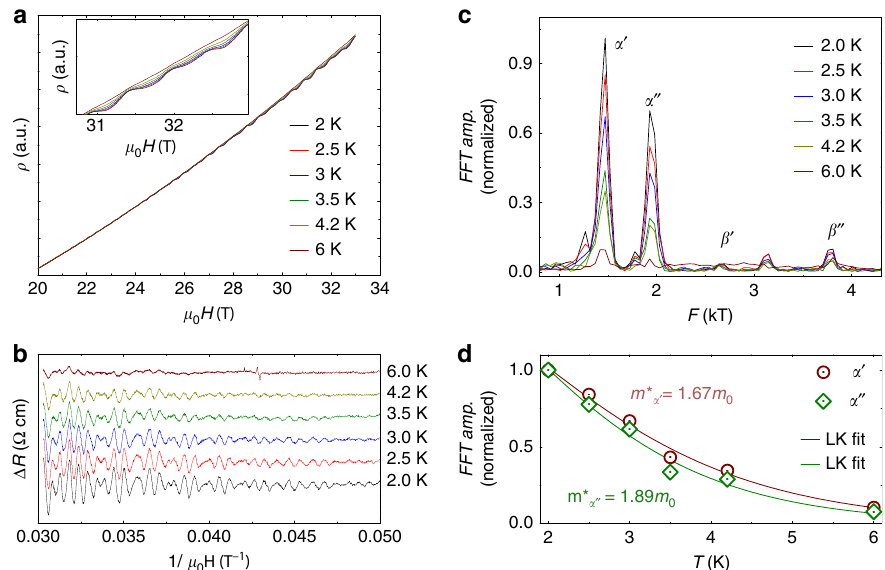
Fig. 4 SdH oscillations in WP 2 in magnetic fi elds up to 33 T of C3. a ρ ( B ) data at different temperatures from 2 to 6 K shows quantum oscillations. Oscillations are clearly visible in the inset with a zoomed in view at high B . b corresponding SdH oscillations amplitudes obtained by subtracting a continuous polynomial. c FFT amplitudes as a function of the temperature showing the peaks corresponding to holes and electron pockets as predicted by calculations. d Effective mass calculations of the hole pockets from the LK formula fi ts to the FFT-amplitude vs T